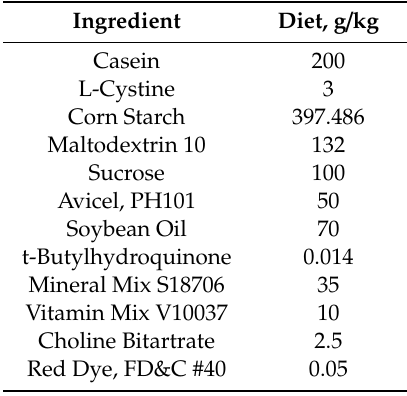
Table 6. Composite of the iron deficiency diet